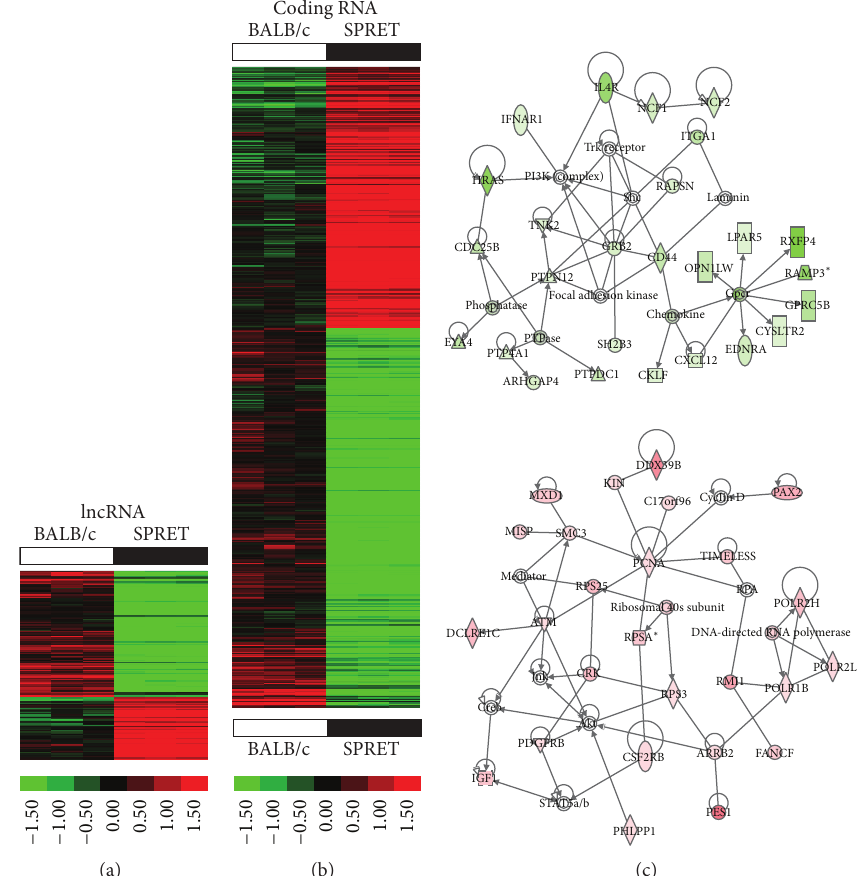
Figure 1: Significant strain differences in lncRNA and coding RNA expression in mammary tissues of BALB/c and SPRET/EiJ mice. (a)-(b) Hierarchical clustering of baseline differences in lncRNA (a) and coding RNA (b) expression in mammary gland tissues of 8-9-week-old BALB/c and SPRET/EiJ mice (fold-change 1.5; 𝑝 value < 0.001). Increased expression indicated in red and decreased expression in green. (c) Gene interaction networks of genes expressed at lower levels in BALB/c mammary tissues when compared to SPRET/EiJ (top) and genes